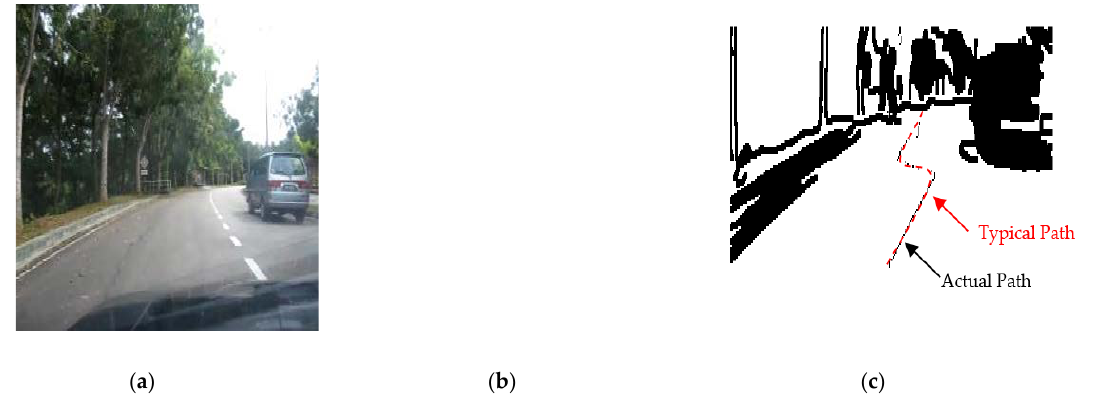
Figure 19. Autonomous detection and navigation of the proposed system in the road following (with 5 m as width and 500 m as length) with a car on the side/in front: ( a ) original image, ( b ) image